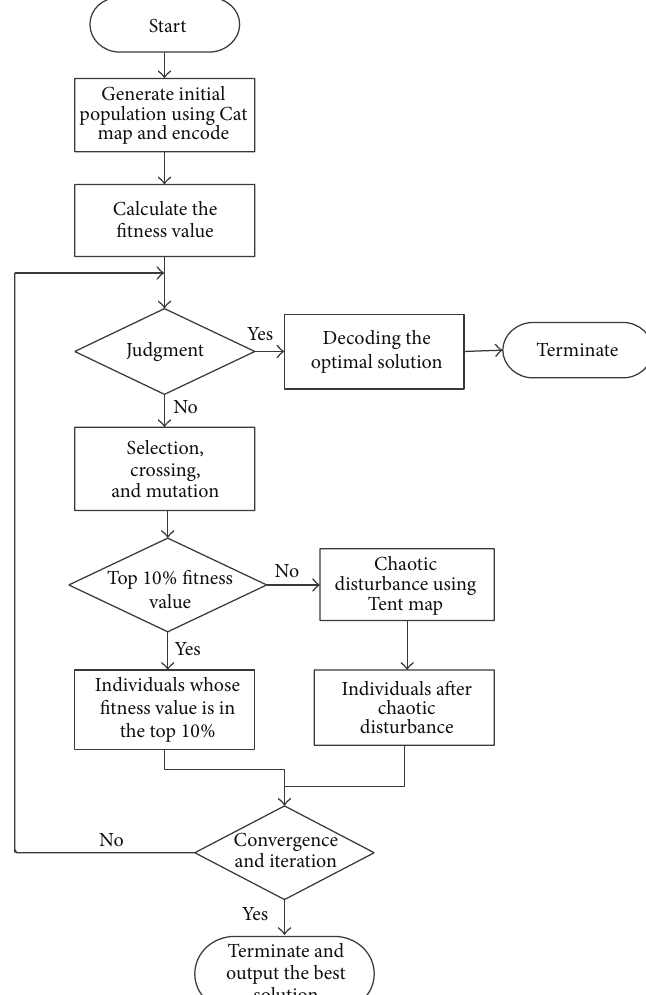
Figure 4: Flow chart for CGA